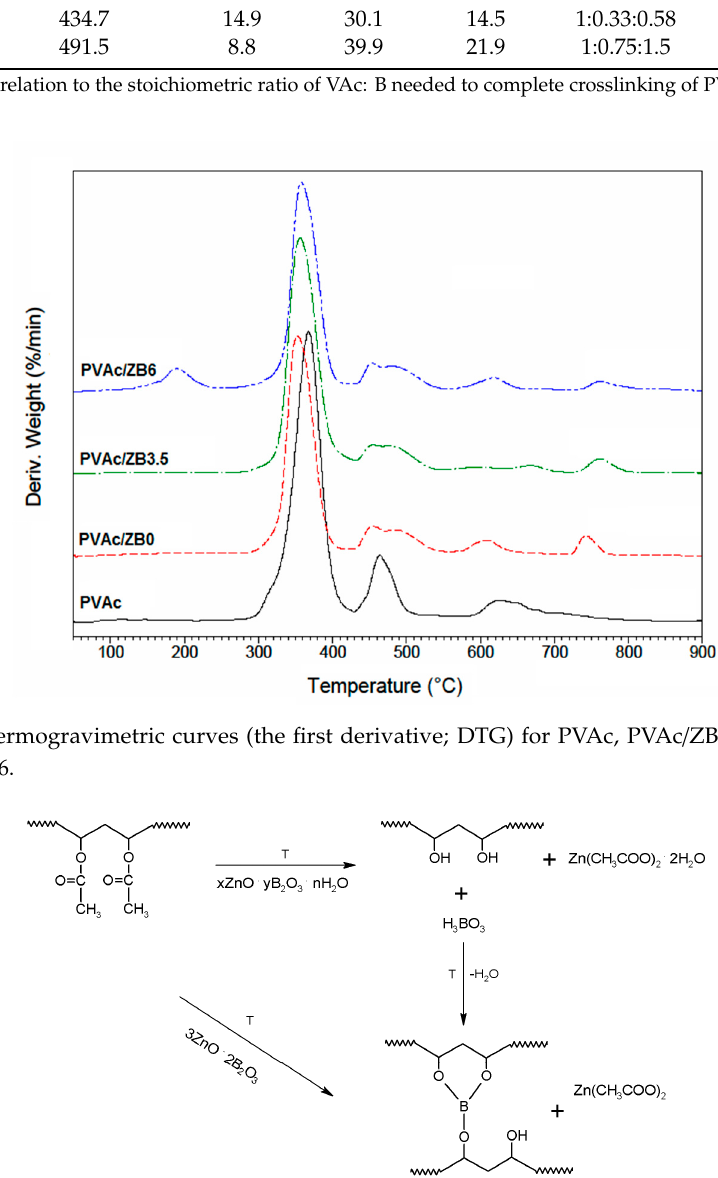
Figure 8. DTG curves for the selected intumescent coatings with various zinc borates.